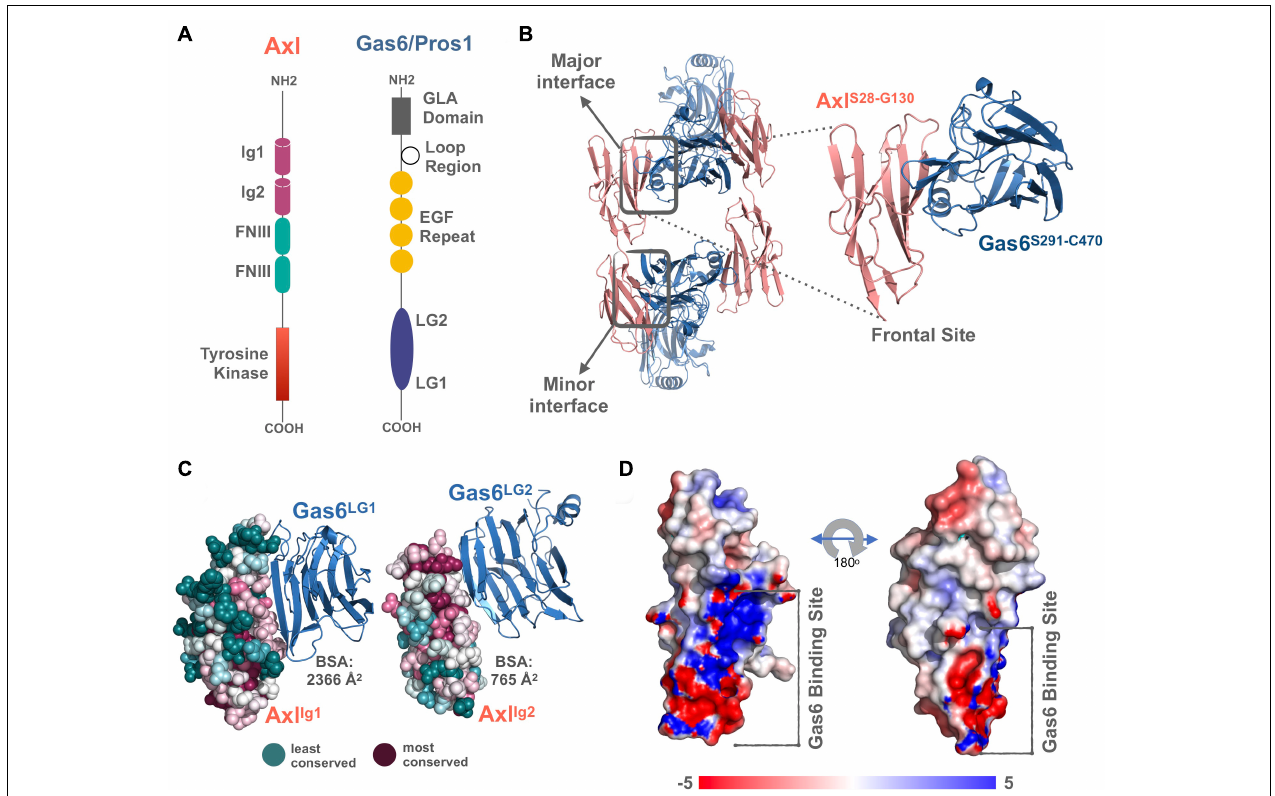
FIGURE 1 | (A) The domain organization of TAM family and its ligands, Gas6 and Pros1. TAM family consists of Ig1, Ig2, two FNIII, and tyrosine kinase domains (Linger et al., 2008; Lemke, 2013). Gas6 and Pros1 are composed of GLA domain, loop region, EGF Repeat, and LG2, LG1 domains (Linger et al., 2008; Lemke, 2013). (B) Axl(Ig1-Ig2):Gas6(LG1-LG2) interaction involves two interfaces: The major interface is formed between Axl-Ig1:Gas6-LG1 and the minor one is established among Axl-Ig2:Gas6-LG1 [PDB ID: 2C5D, Sasaki et al. (2006)]. The inset represents the charged frontal side of the major interface (Axl is depicted in pink cartoon, whereas Gas6 is represented in purple cartoon). (C) Conservation scores of Axl residues predicted via ConSurf webserver (Glaser et al., 2003; Landau et al., 2005; Ashkenazy et al., 2016). The most conserved sites are colored with deep purple and the least conserved ones with deep teal. (D) Electrostatic potential of Axl:Gas6 interacting site. The color scale ranges from -5 (red) to 5 (blue). One side of Axl’s Gas6 binding surface is heavily charged, while the other side is composed of neutral amino